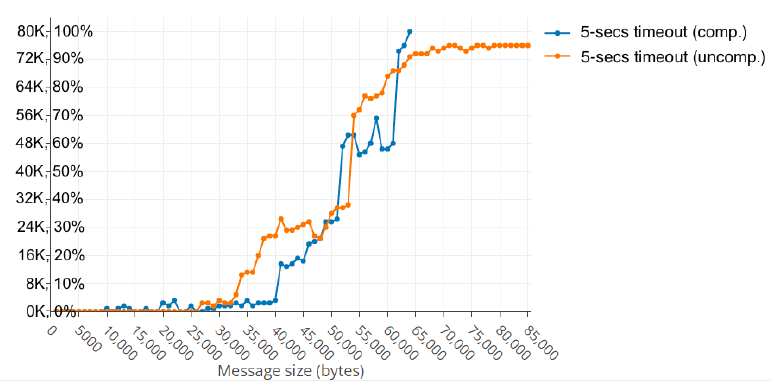
Figure 6. Slow responses rate without compression vs. with compression.